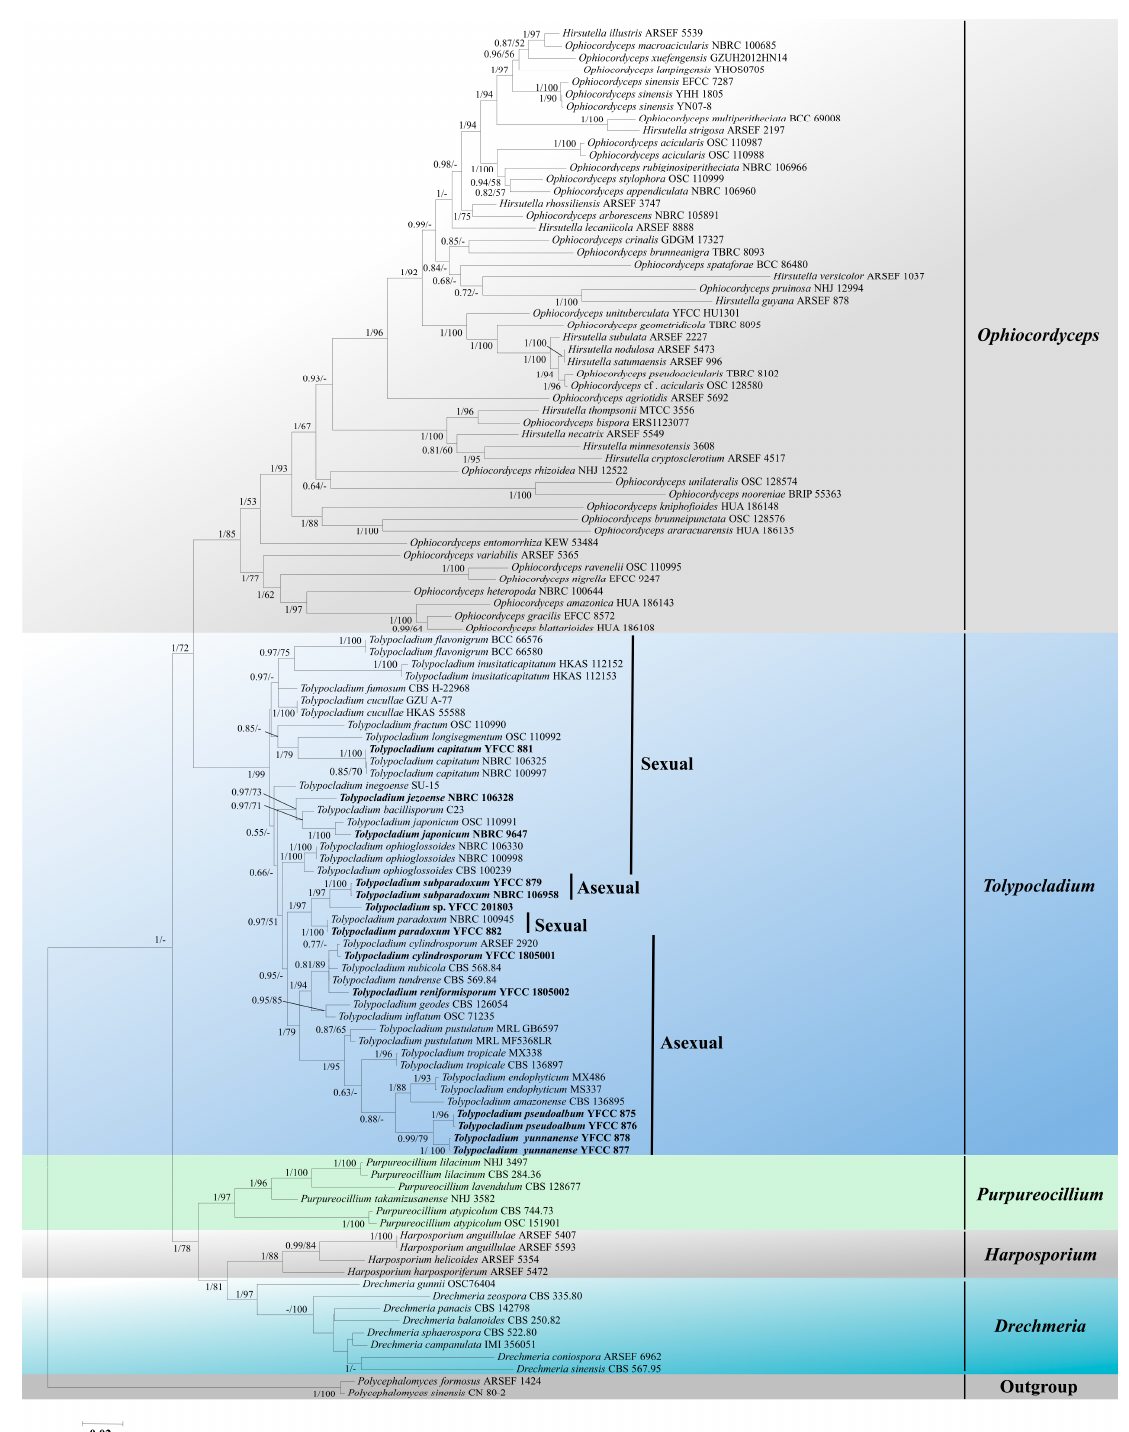
Figure 1. Maximum-likelihood tree illustrating the phylogeny of Tolypocladium based on the combined dataset of nr SSU , nr LSU , tef - 1 α , rpb1 and rpb2 sequences. Polycephalomyces formosus ARSEF 1424 and Polycephalomyces sinensis CN 80-2 were used as outgroups. The maximum-likelihood bootstrap values ( ≥ 50) and Bayesian posterior probability values ( ≥ 0.50) are indicated above the branches. Isolates in bold type are those analyzed in this